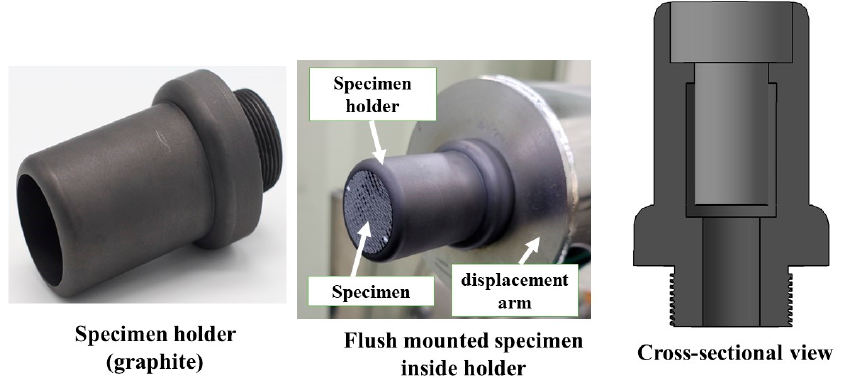
Figure 4. Specimen holder.